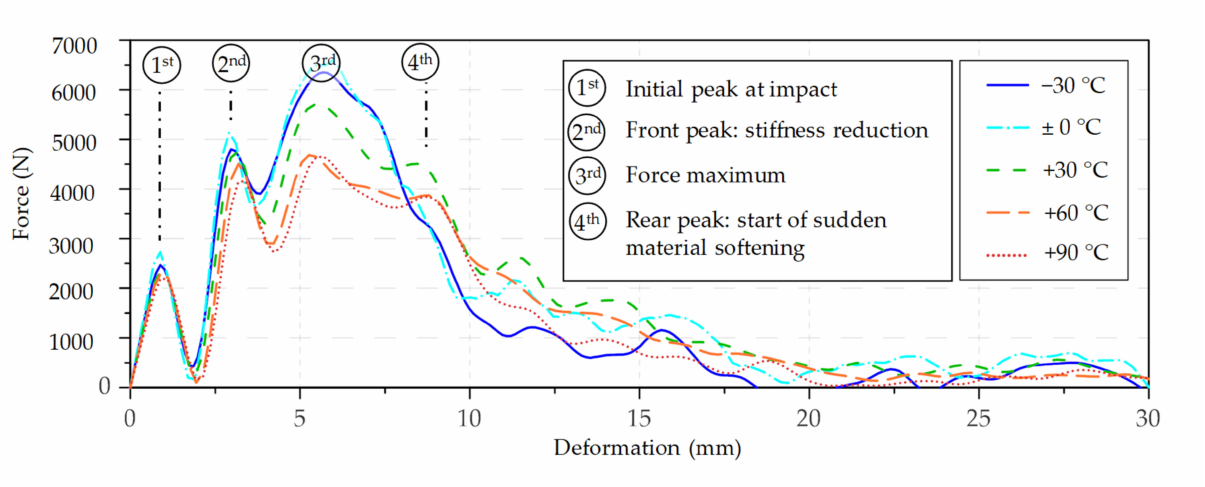
Figure 7. Boxplots of the force maximums from the birch wood tests by temperature level. * An interpretation aid concerning the boxplots can be found in Appendix A, Figure A1.